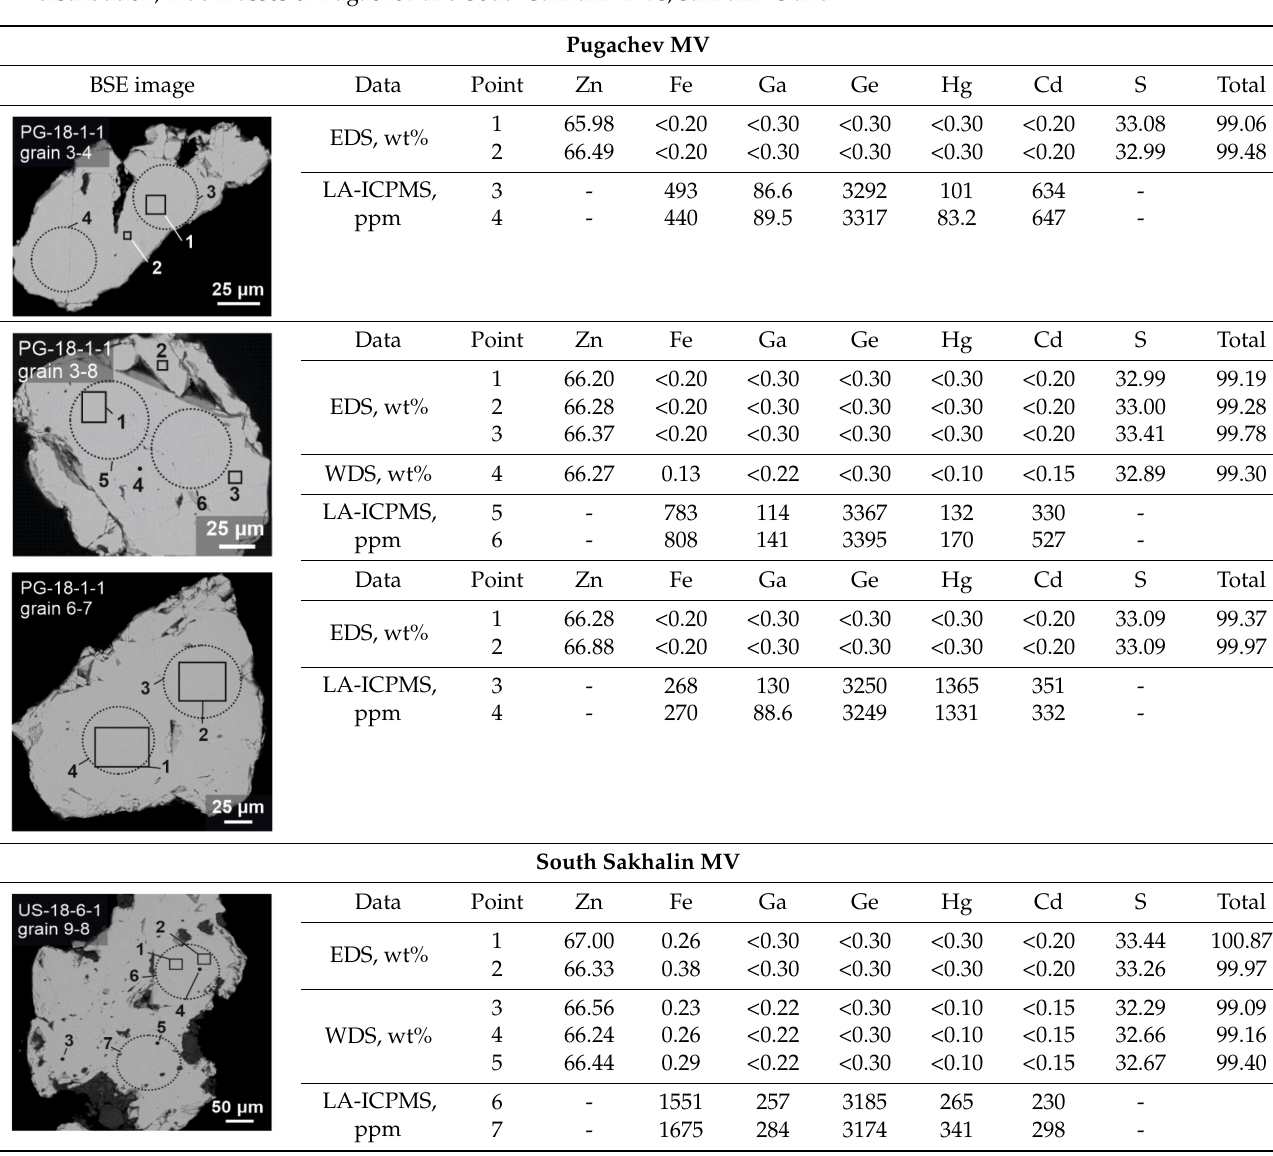
Table 5. Representative back-scattered electron (BSE) images and compositions of sphalerite with homogenous Hg distribution; mud masses of Pugachev and South Sakhalin MVs, Sakhalin Island.